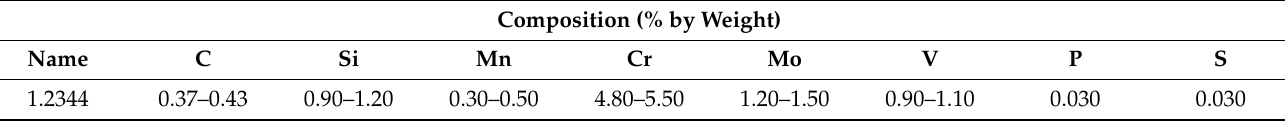
Table 1. Composition (% by weight) of steel H13 (DIN 1.2344). Composition (% by